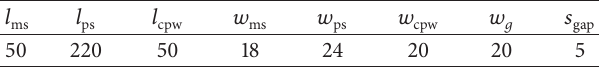
Table 1: Dimensions for frequency tripler transitions (unit: